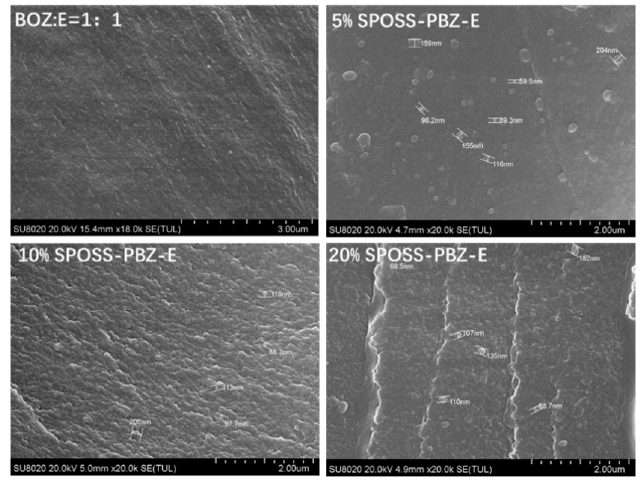
Figure 9. SEM cross-sectional analysis of the SPOSS-PBZ-E Table 2. EDX analysis results of the SPOSS-PBZ-E composites. Table 2. EDX analysis results of the SPOSS-PBZ-E composites.